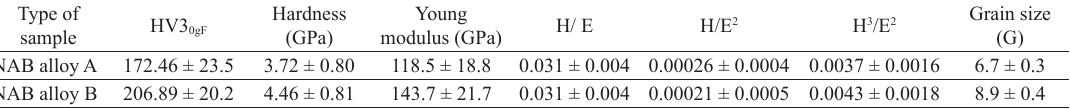
Table 3. Summary of the experimental data derived from the mechanical tests such as nanoindentation curves with their corresponding values of hardness as well as Young modulus and microhardness Vickers (HV) with its relationship with the resultant grain size obtained by ASTM E112-12, respectively.